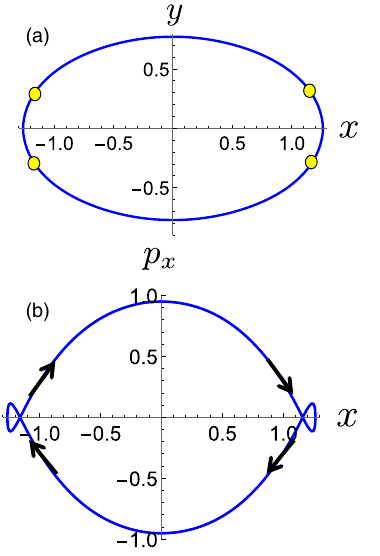
FIG. 10. Critical level set containing the four unstable fixed points for the case τ ¼ − 0 . 4 . (a) Projection into the ð x; y Þ plane. Fixed points are shown in yellow. (b) Projection into the ð x; p plane. Fixed points are located at the two curve self-intersections. Black arrows denote stable and unstable directions near the fixed points. The projection of the level set into the ð y; p similar